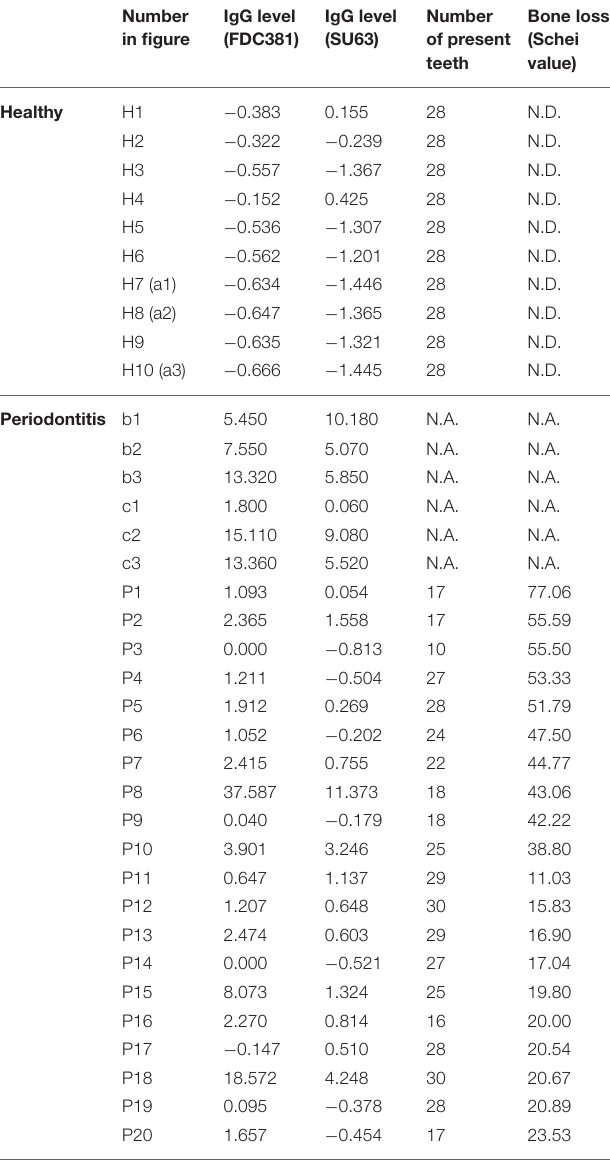
TABLE 1 | Profile of the healthy control group and periodontitis patients. Number in